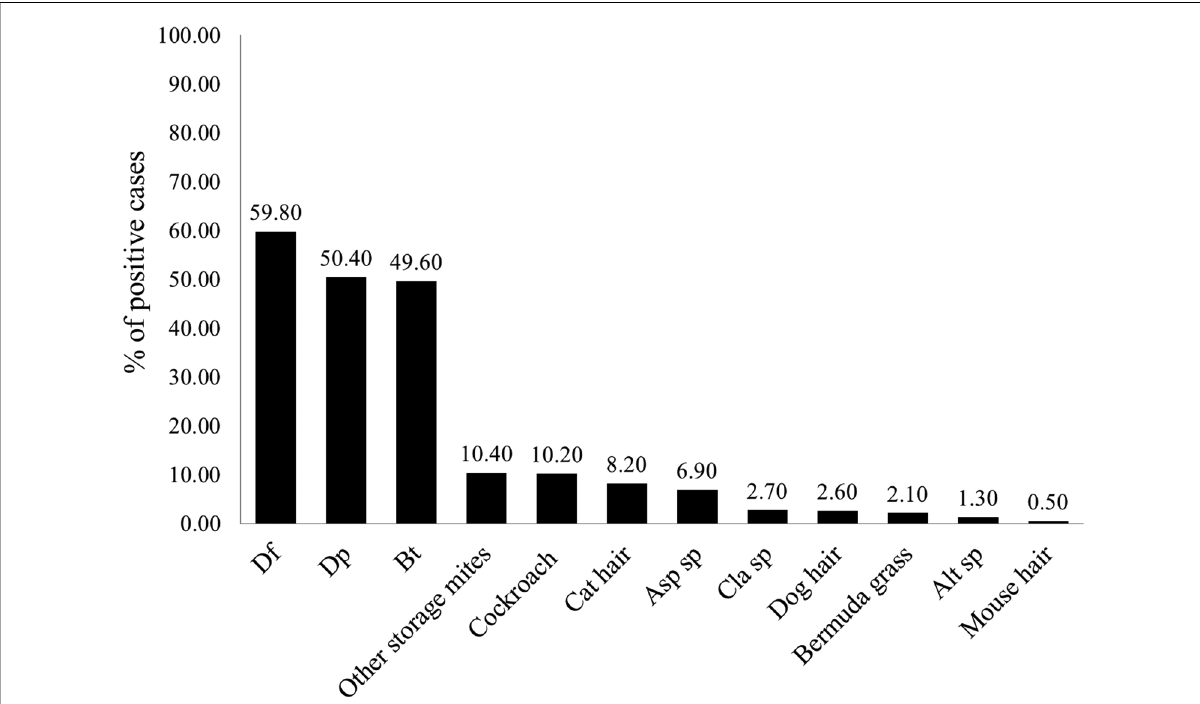
FIGURE 1 The prevalence of positive responses in SPTs to aeroallergens. Data were presented as percentage. The ratio of patients with positive SPT (as de fi ned in the Materials & Methods section) in the study population was